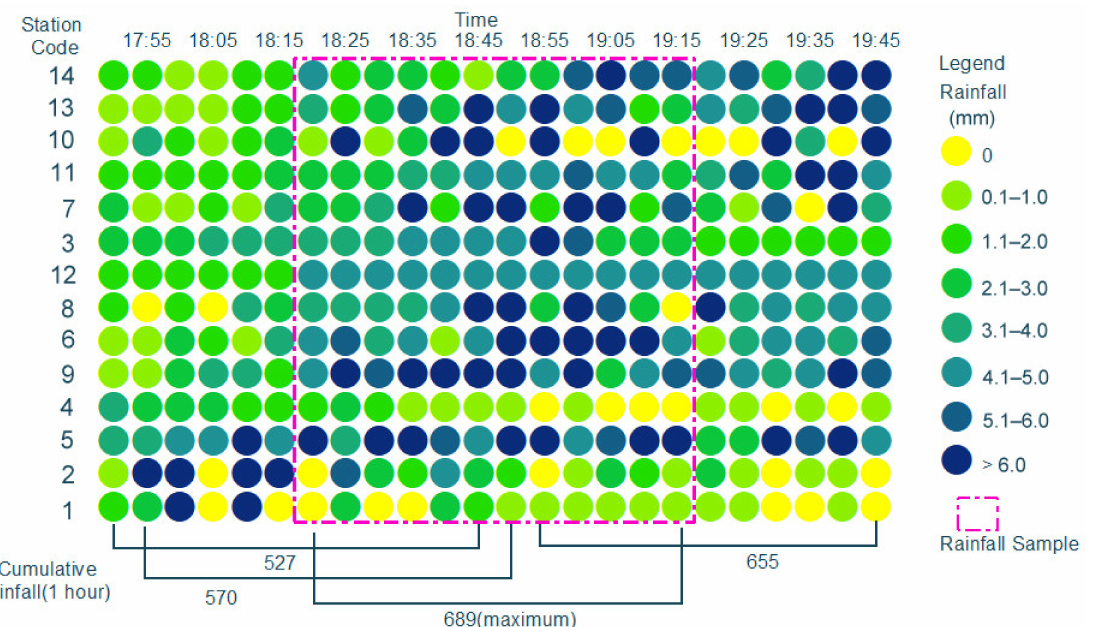
Figure 2. Rainfall of 1-h moving